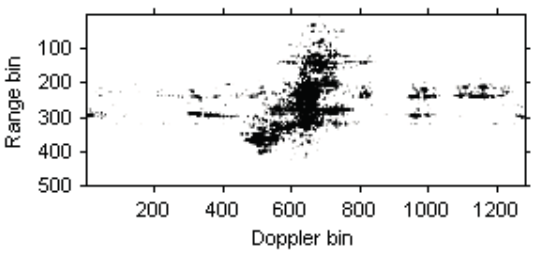
Figure 13. Radar image based on the RD algorithm.